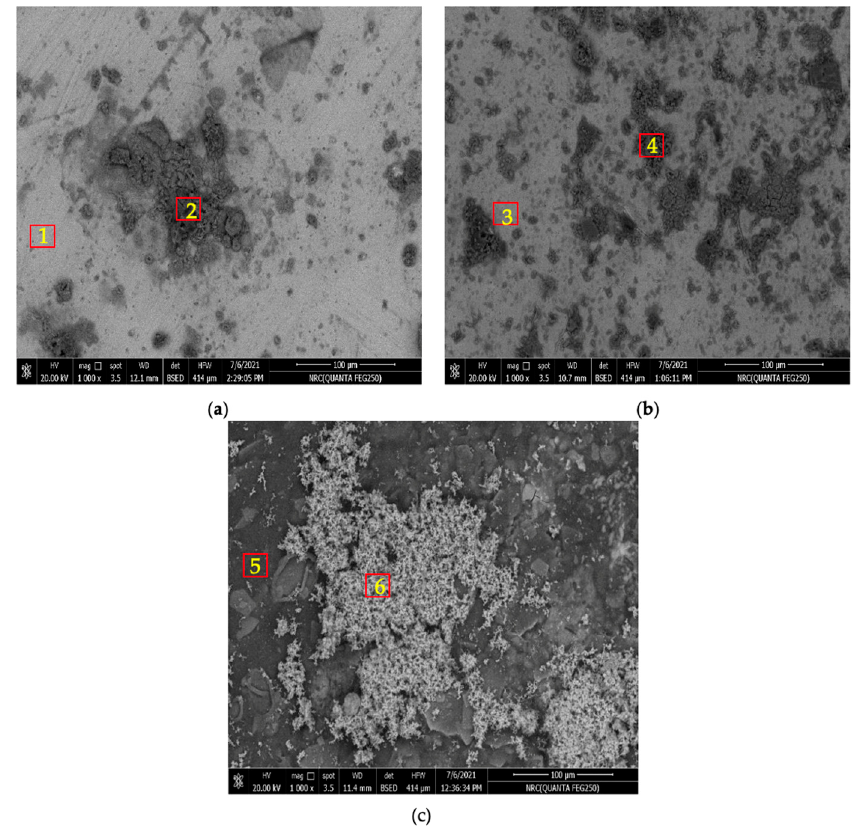
Figure 8. Corroded surface morphology of: ( a ) pure Zn; ( b ) Zn-1.89Mg; ( c ) coated Zn-1.89Mg after 120 h of immersion in SBF. Numbers give indications for the different phases present, EDX analysis in Table S2.